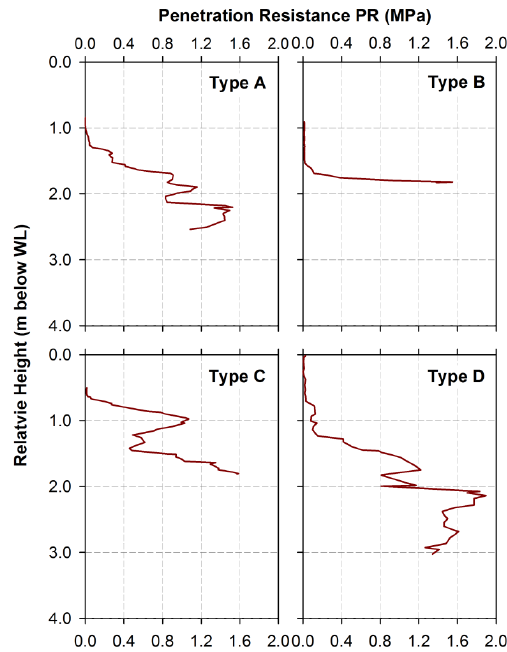
Figure 5. Compilation of the main penetration signal types. They are shown relative to the prevailing water level (WL) at the actual